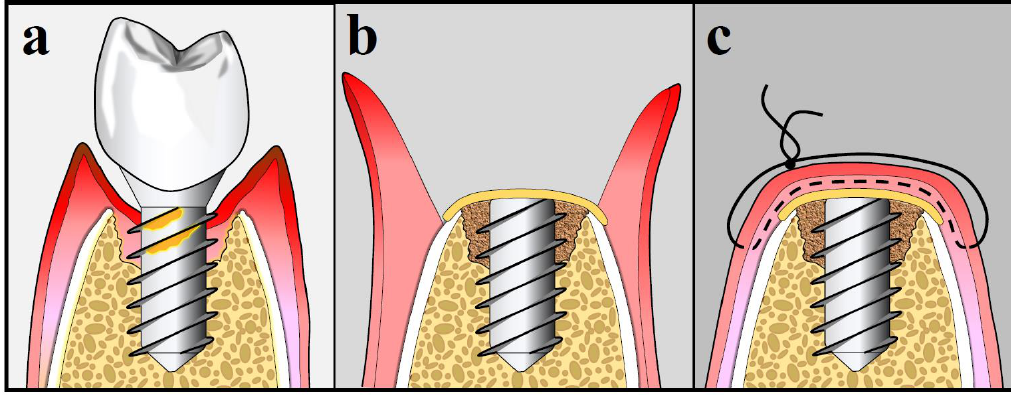
Figure 5. Guided bone regeneration: ( a ) Pre-operative; ( b ) Intra-operative; ( c ) Flap